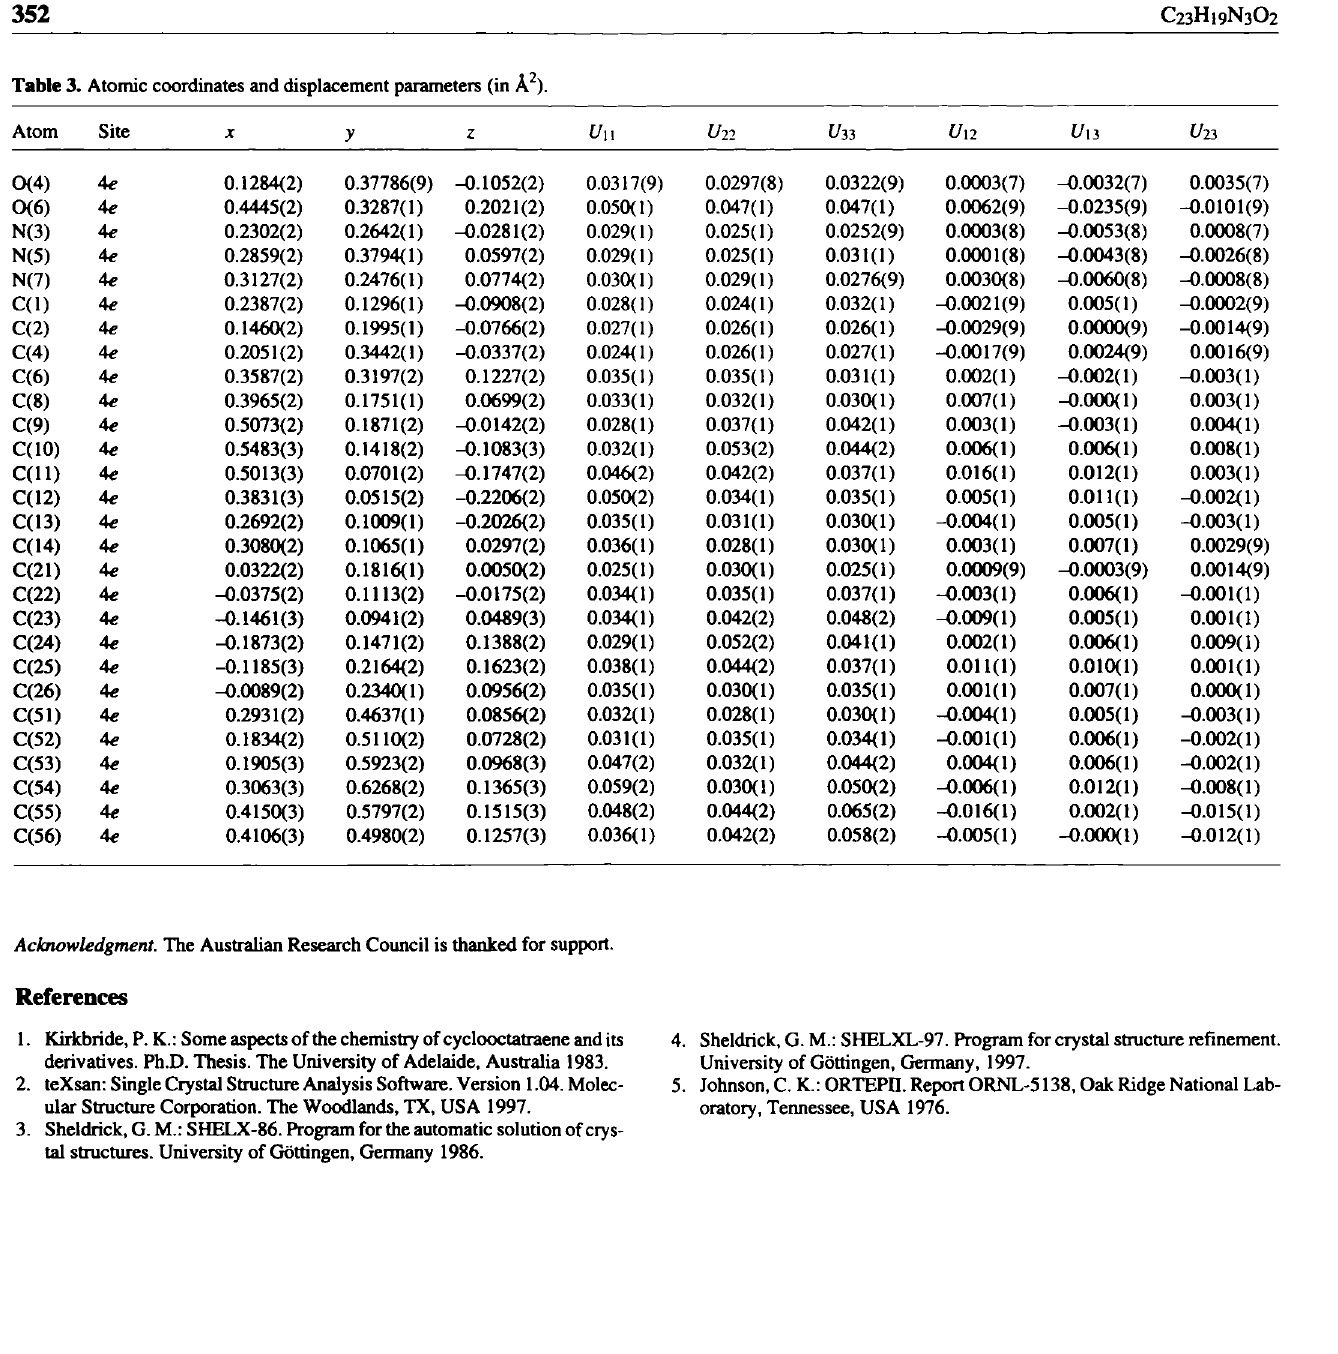
Table 3. Atomic coordinates and displacement parameters (in Â 2